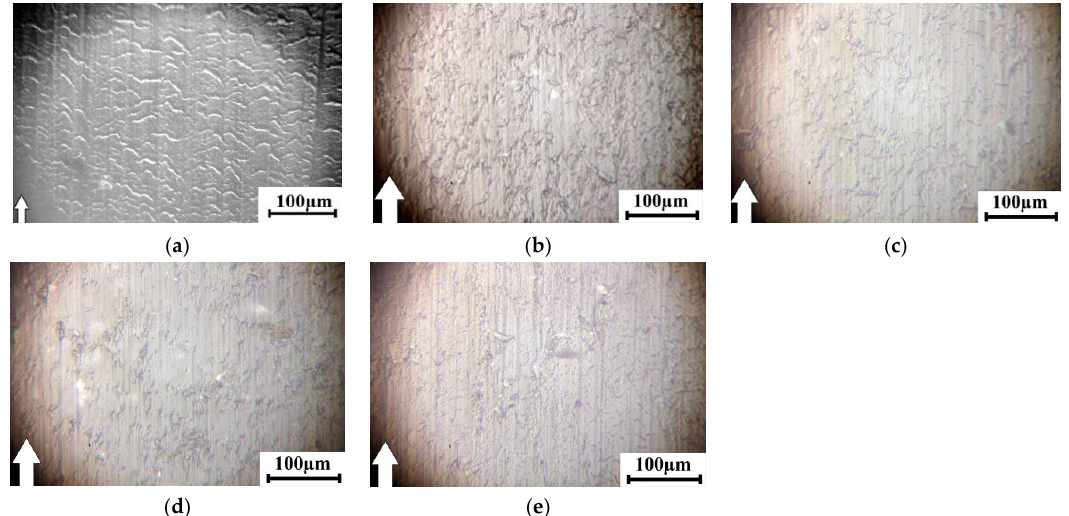
Figure 12. Optical images of the wear track surfaces of neat UHMWPE ( a ); and the “UHMWPE + 15 wt. % wollastonite” composites: untreated ( b ); “KH-550” ( c ); “Penta-1006” ( d ); and “OTS” ( e ) (Load = 140 N, Velocity = 0.5 m ∙ s − 1 )